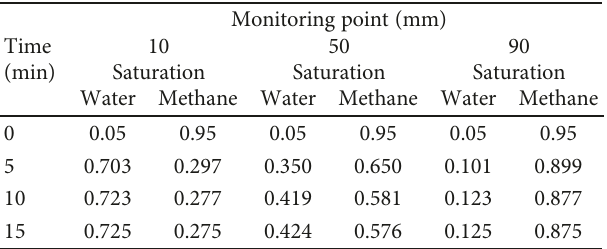
Table 2: Space-time distribution of the water-methane two-phase saturation at the axial monitoring